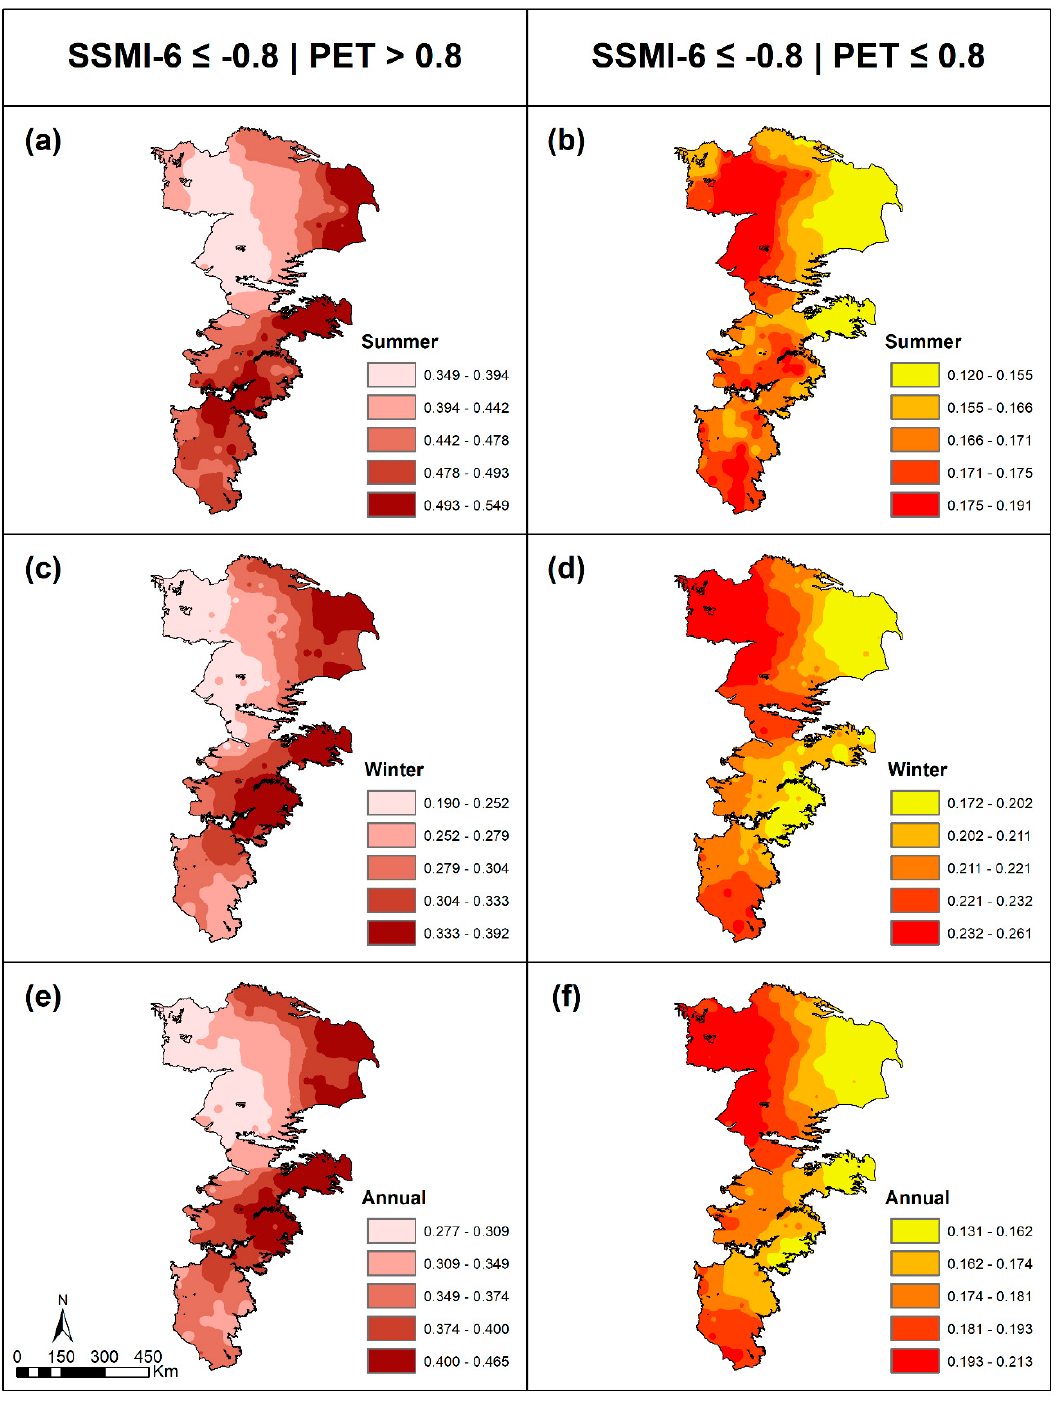
Figure 9. SSMI6 risks of moderate or higher agricultural droughts under standardized PET being at moderate or higher (left panel) and lower than moderate (right panel) conditions ( a – f